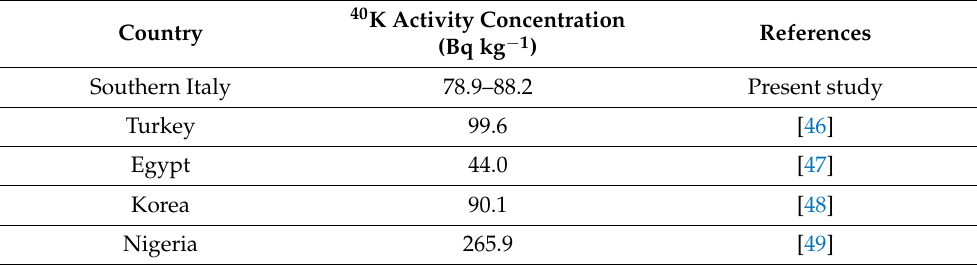
Table 3. Comparison of values of 40 K activity concentration (Bq kg − 1 ) in bovine meat samples of various countries.